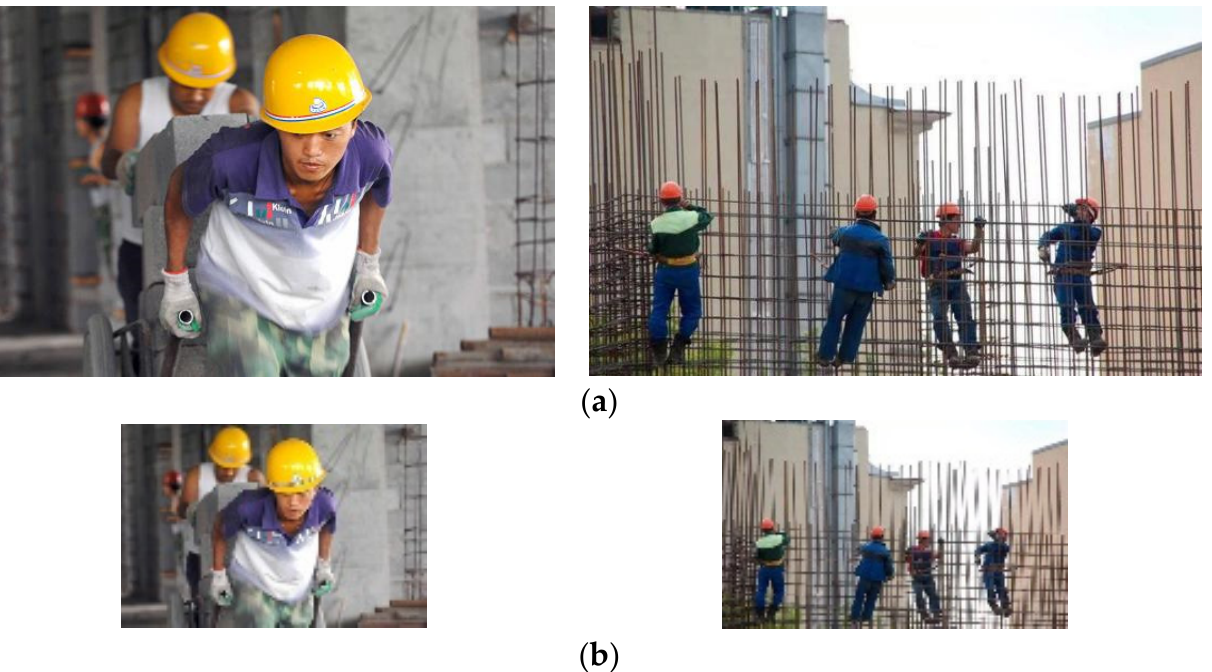
Figure 1. The example of high-resolution images acquired from digital camera and the degraded low-resolution images obtained from the wireless channel due to the constraint of the available transmission bandwidth. ( a ) high-resolution images; ( b ) low-resolution images.